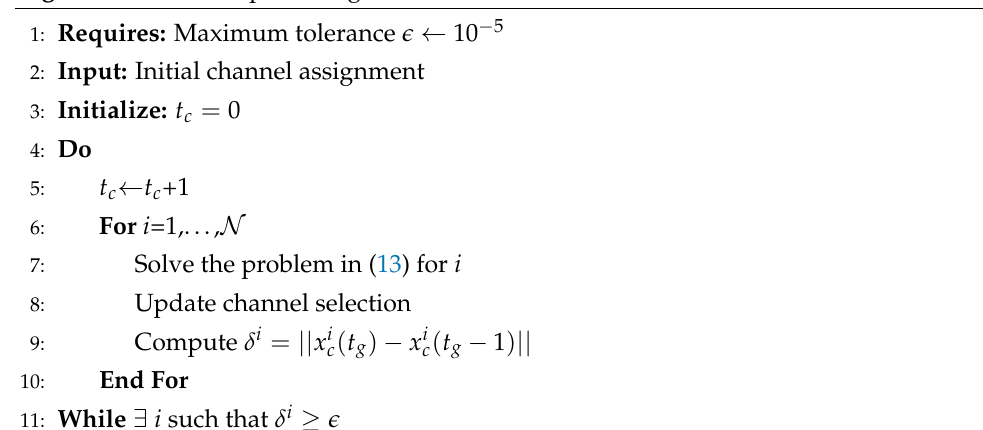
Algorithm 2 Best Response Algorithm for Channel